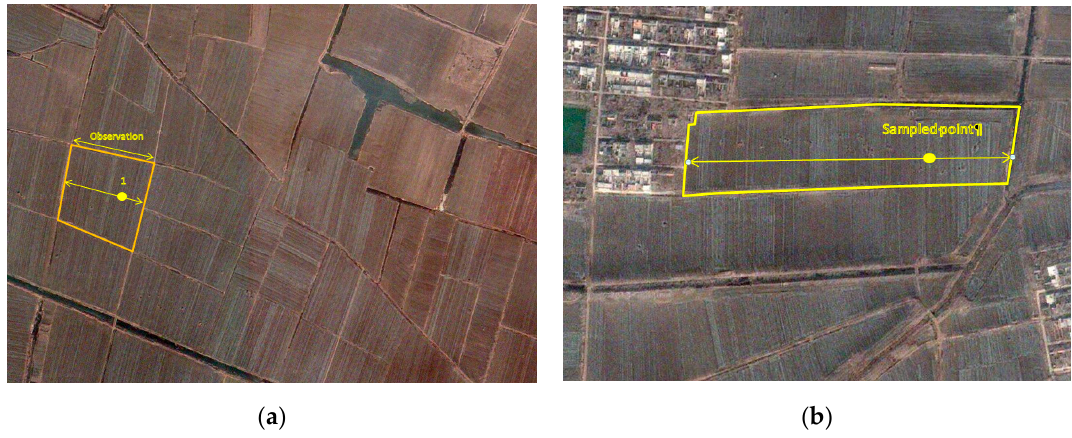
Figure 3. The crop proportion of a particular grid/sample point was assessed by expanding the point to a segment according to the physical boundaries of the field plot harboring the grid/sample point. The proportion of each crop was assessed by global positioning system (GPS) measuring on one border of the plot, perpendicular to the field strips ( a ). The expanded segment can be located on the edge of the agricultural stratum ( b ).